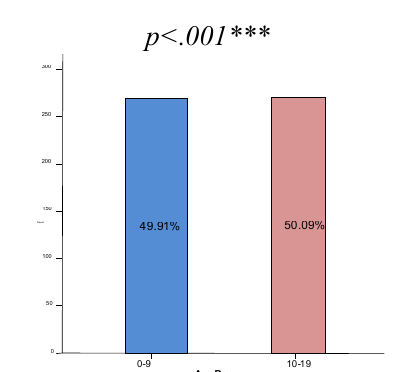
Figure 1: Chi2 test and Anova